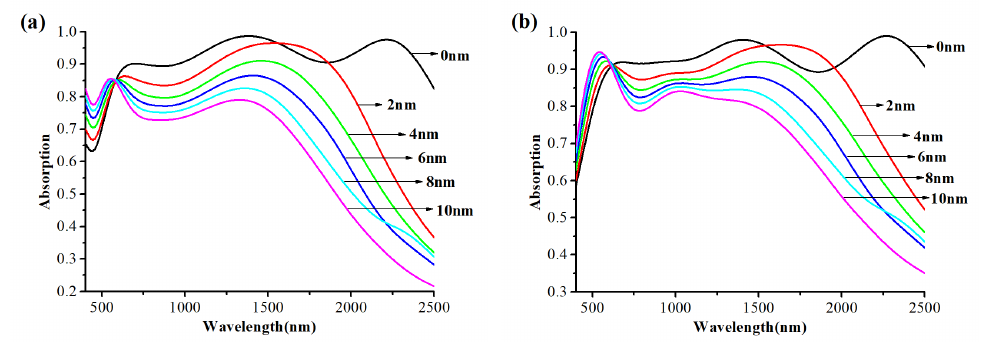
Figure 8. The absorption curves of the absorber with the distance d between nanospheres increasing from 0 to 10 nm: ( a ) the thickness of the MXene layer is 30 nm; ( b ) the thickness of the MXene layer is 400 nm.